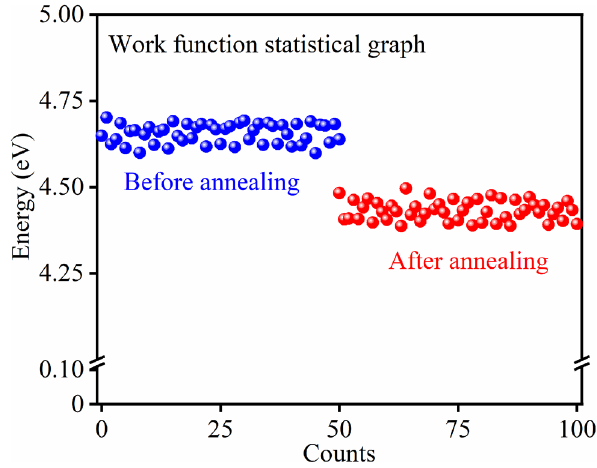
Figure 3: Work functions at different positions of Ti 3 C 2 T x fi